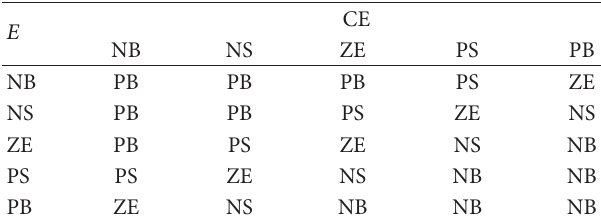
Table 4: The twenty-five fuzzy rules of the third fuzzy subset